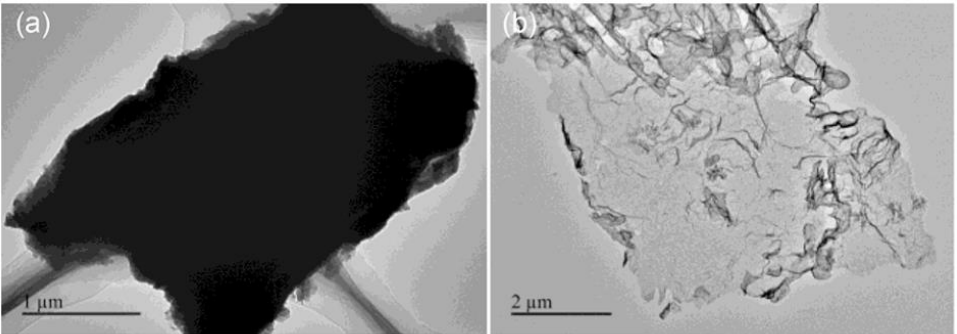
Figure 4. FETEM images of ( a ) bulk C 3 N 4 and ( b ) NS C 3 N 4 . Reproduced with permission from Ref. [55]. Copyright 2017 American Chemical Society.